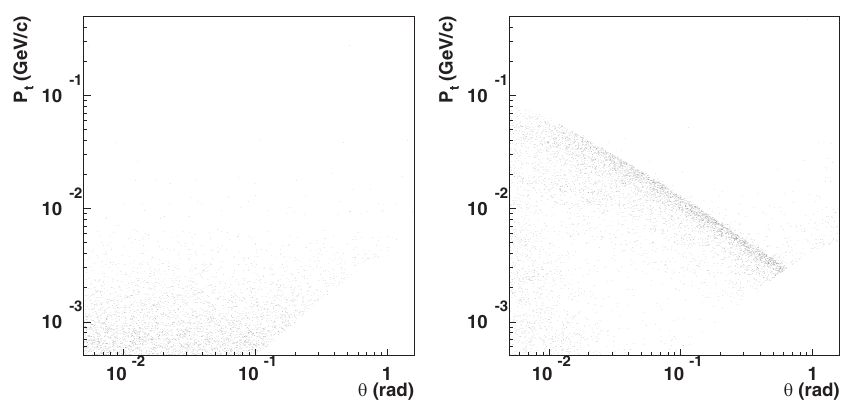
FIG. 2. P versus (cid:1) distributions for IPC particles before (left-hand plot) and after (right-hand plot) electromagnetic deflections from t the opposite